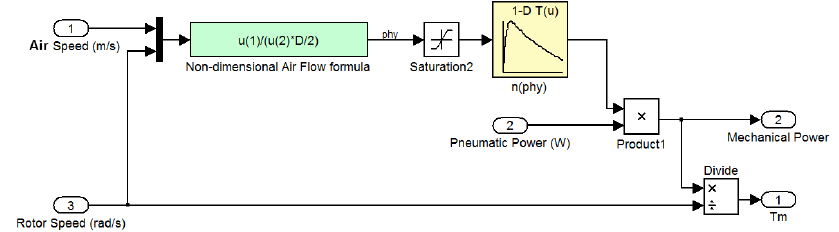
ffi ciency vs. flow coe ffi cient characteristic.